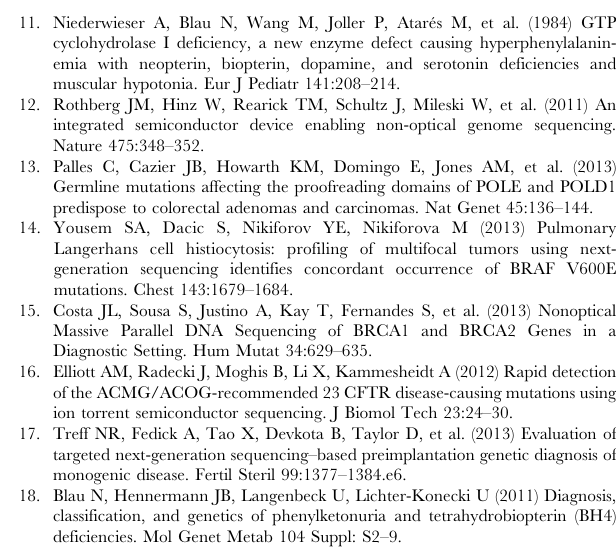
Figure S2 Distribution of insertion/deletion variant (indels) sizes detected by a PGM. Figure S3 The result of six novel mutations in the PAH gene confirmed by Sanger sequencing. (A), (B), (C), (D), (E) and (F) indicate c.272A . G/c.259C . T, c.669delC/c.823C . A,